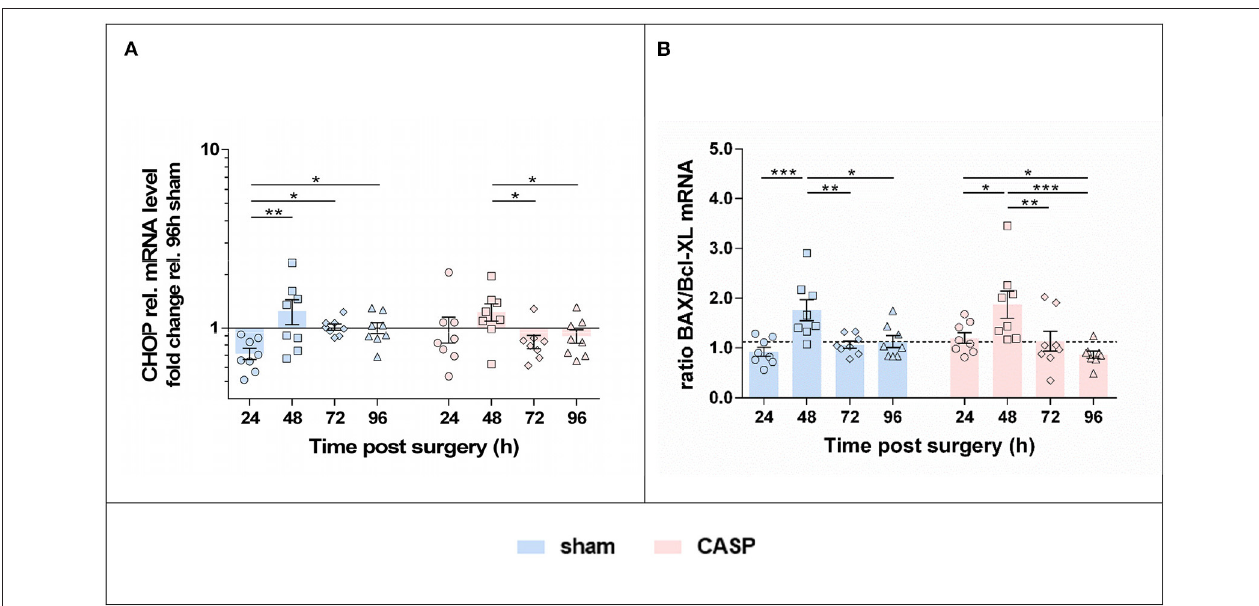
FIGURE 5 | UPR triggers a pro-apoptotic shift with maximum at 48h after surgery. Gene expression levels of (A) CHOP, (B) BAX and Bcl-XL mRNA were determined by means of qPCR in liver samples after sham and CASP surgery. Data from BAX and Bcl-XL expression are presented as a ratio. The dashed line indicates the mean value of the sham group at 96 h. All data are shown as mean ± SEM ( n = 8 per group). Statistical difference was calculated using two-way ANOVA followed by uncorrected Fisher’s LSD test and is indicated by * p < 0.05, ** p < 0.01, and *** p <